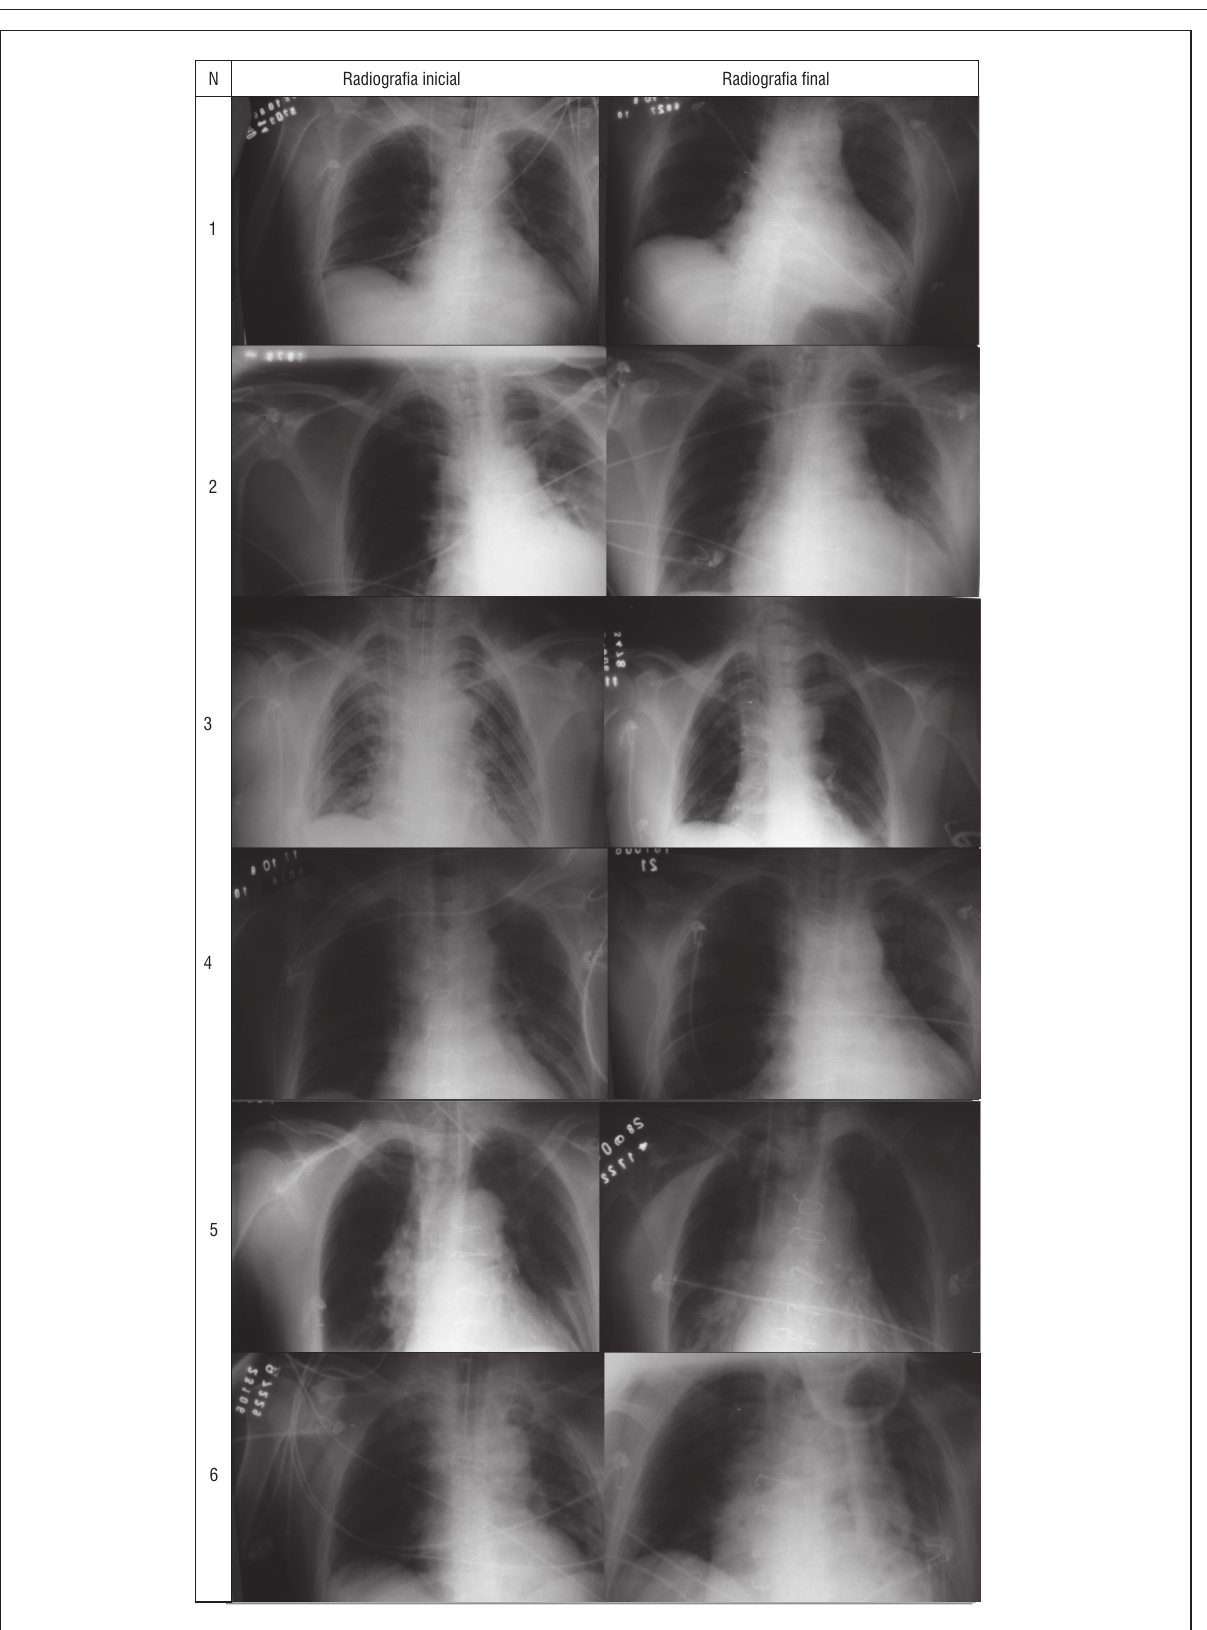
Figura 3 - Radiografias iniciais comparadas às radiografias finais dos seis pacientes avaliados Fonte: Dados da